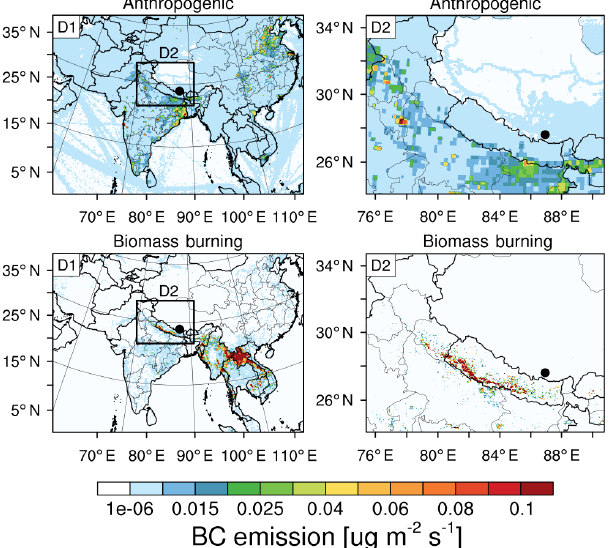
Figure 1. Anthropogenic and fire emissions over the simulated re- gions with 20 and 4km resolutions; the black dot represents the Qomolangma station (QOMS; 86.95 ◦ E, 28.36 ◦ N).